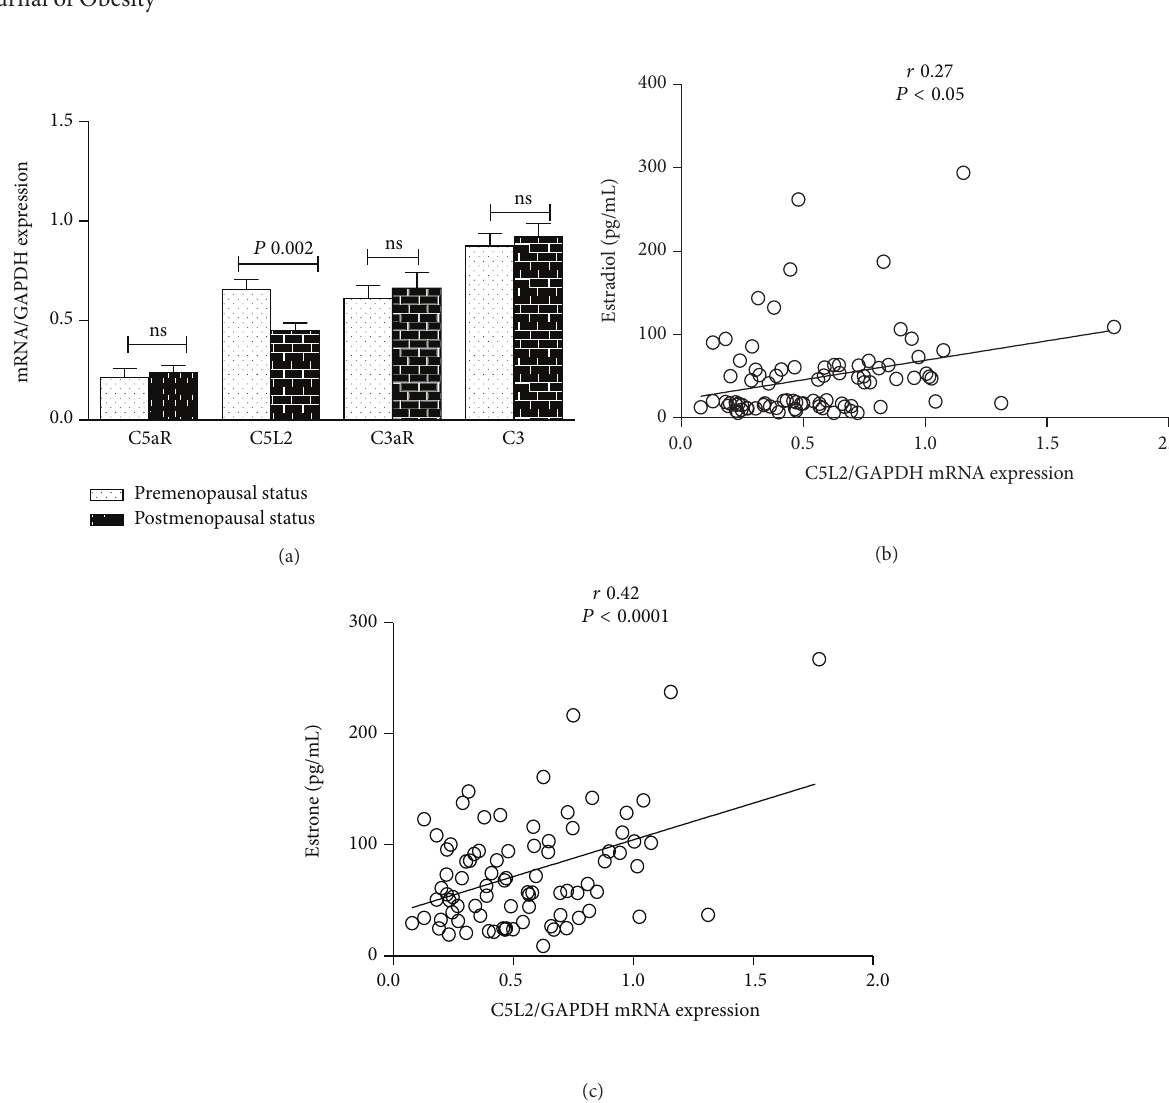
Figure 1: Association of liver C5L2 mRNA expression with circulating estrogen levels. mRNA was extracted from liver biopsies and reverse- transcribed to cDNA and gene expression was evaluated by RT-PCR with the indicated primers with all results expressed relative to GAPDH using the ΔΔ Ct method as described in detail in Section 2. (a) Hepatic mRNA expression levels of C3 and the three related receptors (C5L2, C3aR, and C5aR) in the pre- versus postmenopausal groups. ((b) and (c)) Linear correlation plot of C5L2 mRNA expression with plasma estradiol (E2) and estrone